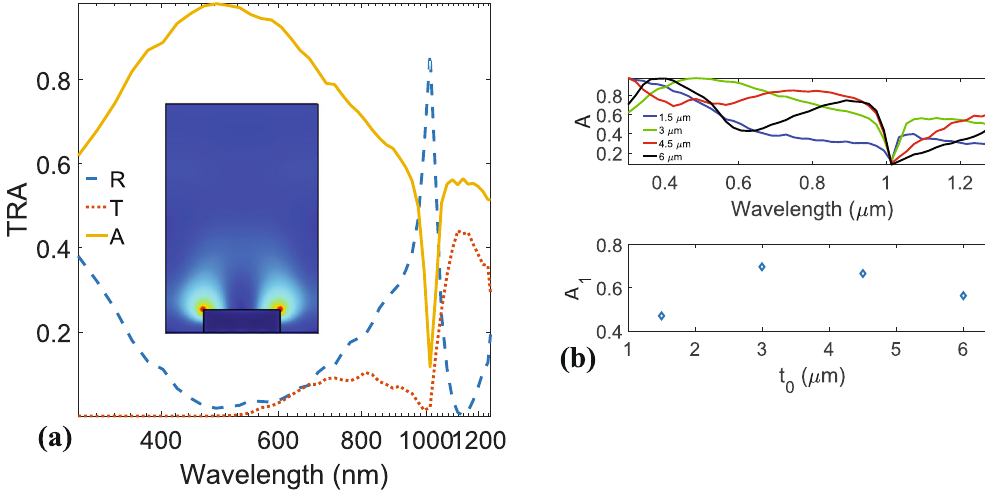
Figure 2. ( a ) Transmission, reflection and absorption spectra (T, R, and A) of the grating. The inset shows the magnitude of electric field at around λ µ = m 1 . ( b ) Absorption for different thicknesses (up) and integrated λλ absorption ( ∫ λ λ d A ( ) 1 minmax ) versus thickness t 0 ∆ λ